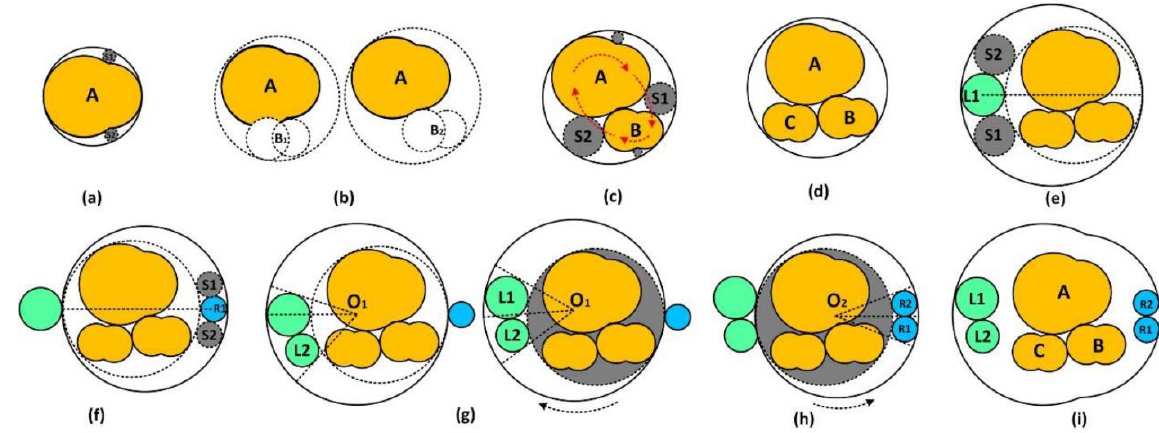
Figure 8. Layout process of child nodes.